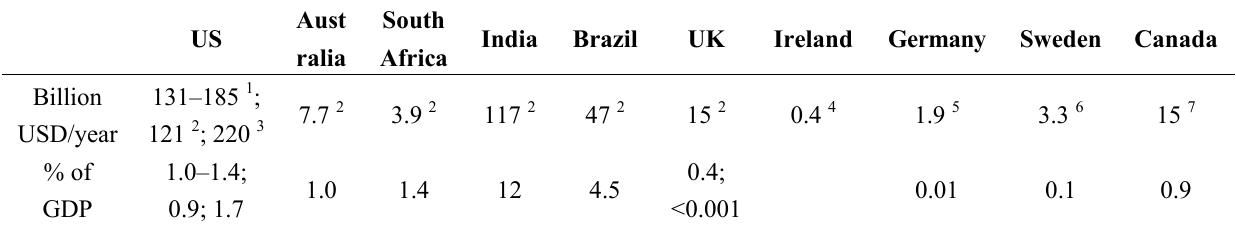
Table 1. Studies with national scale and estimates of damage costs of invasive species (billion USD per year in 2008 prices and % of